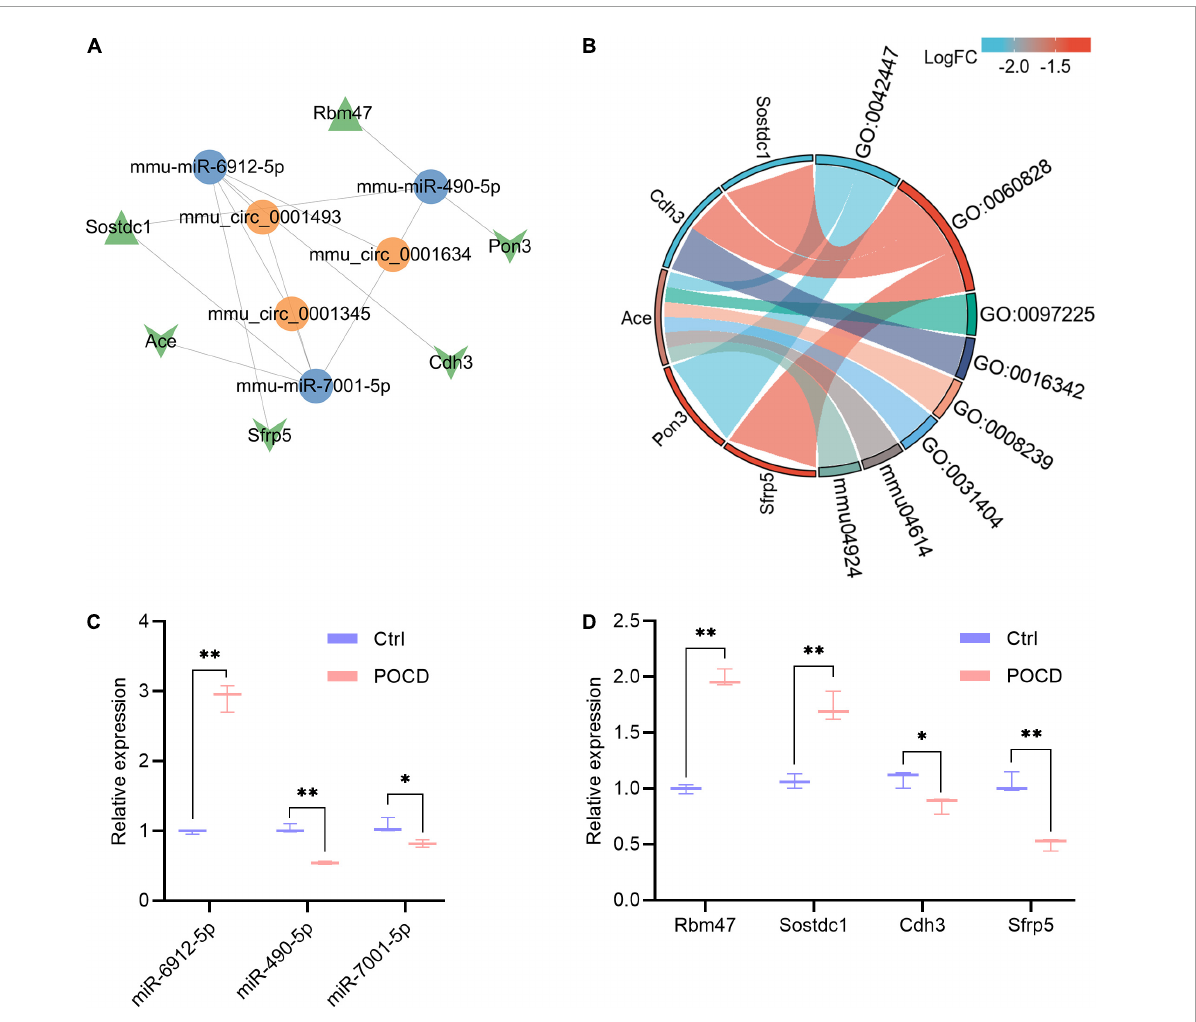
FIGURE6 Potential competing endogenous RNA (ceRNA) regulatory network, enrichment analysis of DEmRNAs in the ceRNA network, and qRT-PCR validation of three miRNAs and four mRNAs. (A) The ceRNA regulatory network includes three circRNAs, three miRNAs, and six mRNAs. The orange color indicates circRNAs, the blue color indicates miRNAs, and the green color indicates mRNAs (Triangle and V denote upregulation and downregulation, respectively). (B) Functional classifications and pathway enrichment analysis (GO and KEGG) of DEmRNAs in the ceRNA network. The right half part indicates enriched biological process (BP), cellular component (CC), molecular function (MF), and KEGG pathway; the left half part indicates the genes involved in the corresponding BP, CC, MF, and pathways. GO:0042447, hormone catabolic process; GO:0060828, regulation of canonical Wnt signaling pathway; GO:0097225, sperm midpiece; GO:0016342, catenin complex; GO:0008239, dipeptidyl-peptidase activity; GO:0031404, chloride ion binding; mmu04614, renin-angiotensin system; mmu04924, renin secretion. (C,D) Quantitative RT-PCR validation of miR-6912-5p, miR-490-5p, miR-7001-5p, Rbm47, Sostdc1, Cdh3, and Sfrp5. Target miRNA expression were normalized to U6 expression, and mRNA expression were normalized to GAPDH expression ( (cid:49) Ct). Non-parametric test, * p < 0.05, ** p < 0.01 compared to the control